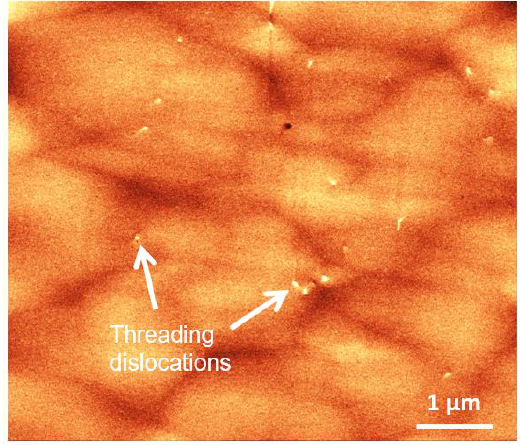
Figure 3. ECCI image of the GaAs/Si template with In 0.1 Al 0.9 As/GaAs SLS showing threading dislo- cations.